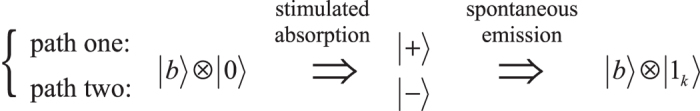
The interference pathways in EIT system.The two pathways, which form the interference pair, are stimulated absorption (from  to  and ), and the spontaneous emission (from  and  to ).